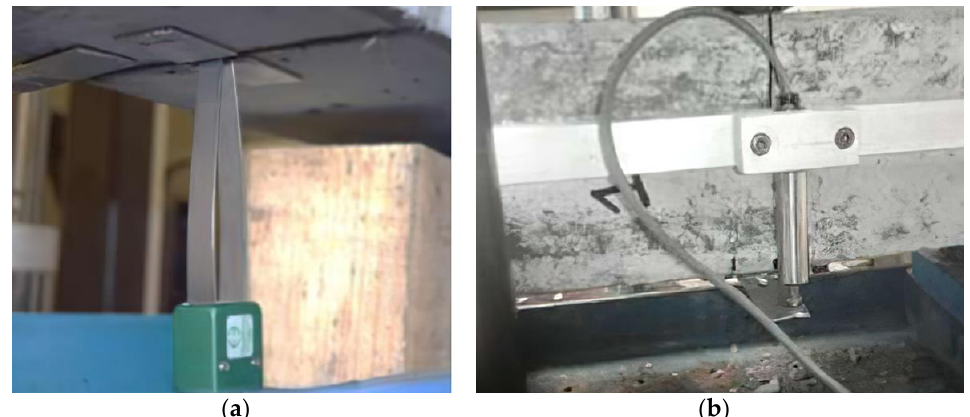
Figure 1. Tensile bending test in prismatic specimens. ( a ) Measurement of the crack-mouth opening by means of extensometer clip-type Epsilon brand. ( b ) Measurement of the deflection at midspan of specimen through a linear variable differential transformer (LVDT), VISHAY